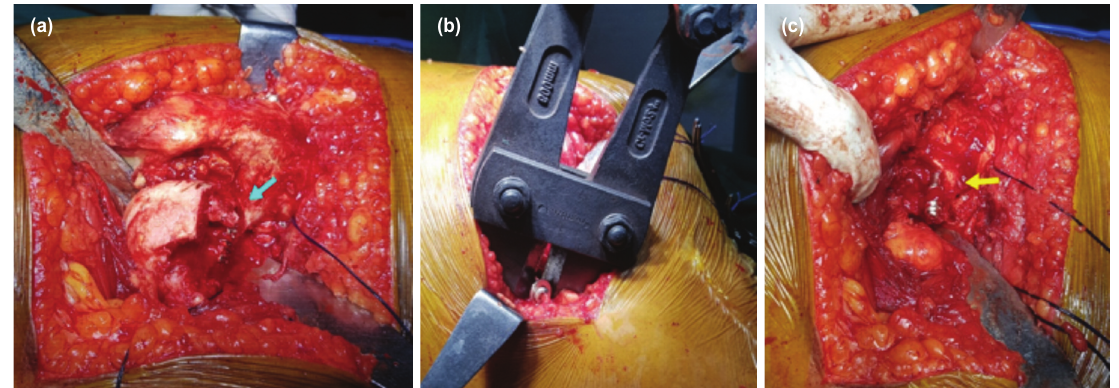
(a) Intra-operatively posteriorly dislocated right hip with exposed screw marked with blue arrow, (b) Harrington cutter for distal Fig. 2: screw cut out, (c) screw abutment marked with yellow arrow at inferior femoral neck region.